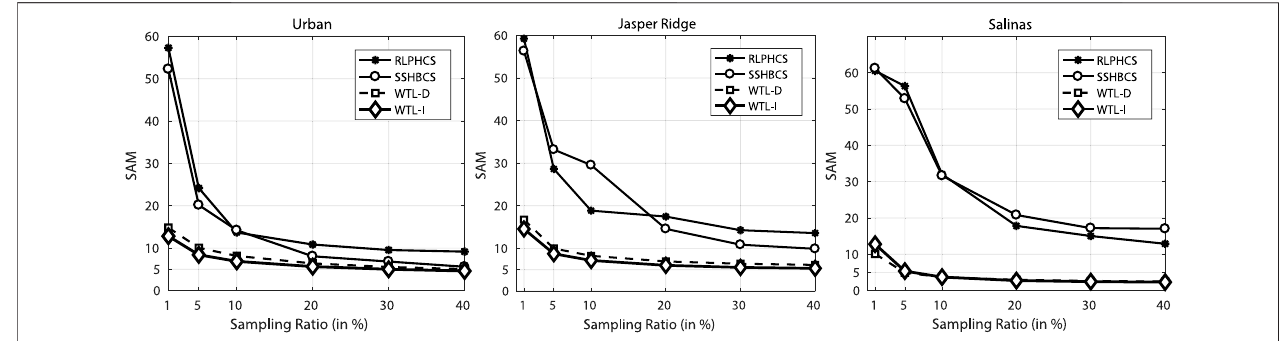
FIGURE11 | Reconstruction performancecomparison ofWTL-D, WTL-I, SSHBCS, and RLPHCSin terms of SAM fordata sets: (A) Urban, (B) Jasper Ridge, and (C) Salinas. Results are generated for images corrupted with noise, having an SNR of 20 dB.